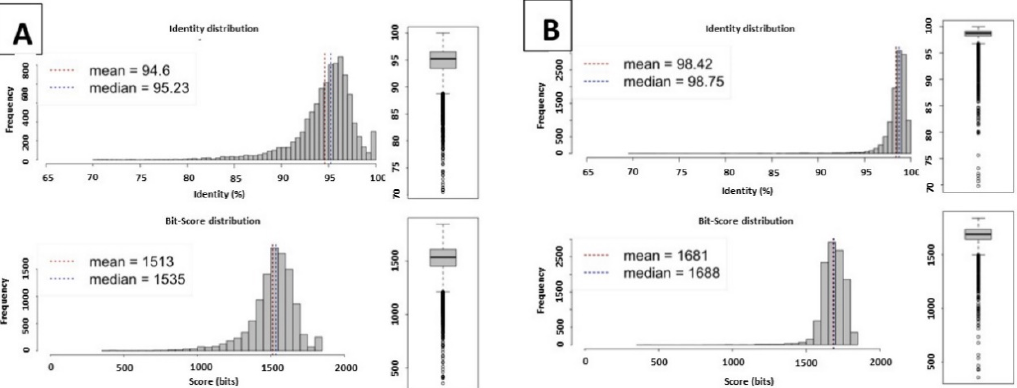
Figure 1. Estimation of the distribution of nucleotide identity between fragments of two genomic datasets. The estimation was conducted with an ANI calculator established by Kostas Lab according to calculations by Goris et al. [13]. ( A ) shows a representative of data on the 9 isolates with ANI at ≥ 94.6%; ( B ) shows a representation of data for the remaining 31 isolates with ANI at >98%.